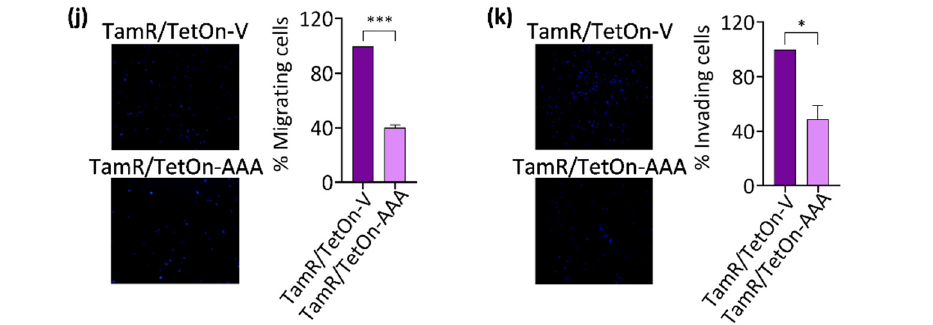
Figure A1. A re-expression affects the progression of TamR BCCs. Tamoxifen-resistant T-47D/TR and ZR-75/TR and the relative parental cell lines were subjected to migration ( a , b ) and invasion ( c , d ) experiments, as described in Section 2. Dox-inducible FoxO3a/TamR stable cell line (TamR/TetOn- AAA) and the corresponding control cell line (TamR/TetOn-V) were treated with Dox 1 µ g/mL for 48 h. The efficiency of FoxO3a induction was evaluated both at the ( e ) mRNA and ( f ) protein levels. mRNA content was normalized vs. its 18S rRNA content. β -Actin was used as a loading control ( g ). Cells were seeded in PRF-GM plus Tam 1 µ M. The day after, medium was refreshed, and cells were treated with Dox 1 µ g/mL. Medium was replaced every 48 h, and cells were counted after 72 h. ( h ) Cells (10 6 ) were seeded in GM on agar stratified 100 mm dishes, treated with Dox 1 µ g/mL, and monitored for up to 72 h. Dox was renewed after 48 h. Images were taken at 10 × magnification. The graph represents the mean of spheroids number and size. ( i ) Confluent cells were subjected to wound-healing scratch assay and treated with Dox 1 µ g/mL. Dox-induced FoxO3a (TamR/TetOn-AAA) significantly hinders wound closure at all time points compared to the control cell line (TamR/TetOn-V). Proteins were collected from a duplicate set of cells and subjected to WB analysis to assess the efficiency of FoxO3a induction (right panel). Cells were seeded, treated with Dox 1 µ g/mL for 48 h, and then harvested with Versene and subjected to migration ( j ) and invasion ( k ) assays. All graphs represent the mean ± s.d. of at least three independent experiments (* p ≤ 0.05, ** p ≤ 0.01, *** p ≤ 0.001).